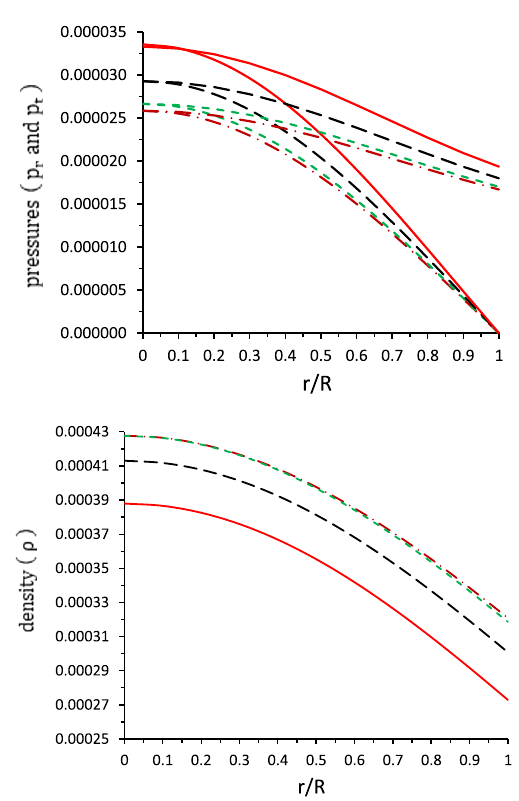
Fig. 3 The behavior of the radial pressure ( p r ) tangential pressure ( p t ), and energy density ( ρ ) versus radial coordinate r / R . The different curves describe the following compact objects namely the red curve (solid) for 4U 1538-52, black curve (long-dashed) for SAX J1808.4- 3658, green color (small-dashed) for SMC X-1, vermilion color (dot- dashed) for LMC